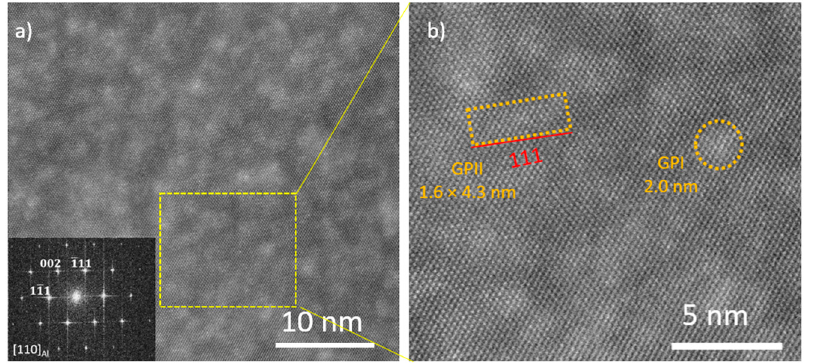
Figure 10. ( a ) HRTEM image of the as-cast B-0.5Cu-NP sample natural aged for 40 days. Inserted is the corresponding fast Fourier transform (FFT) pattern. ( b ) Image of the region in the yellow square with marked GPI and GPII zones.